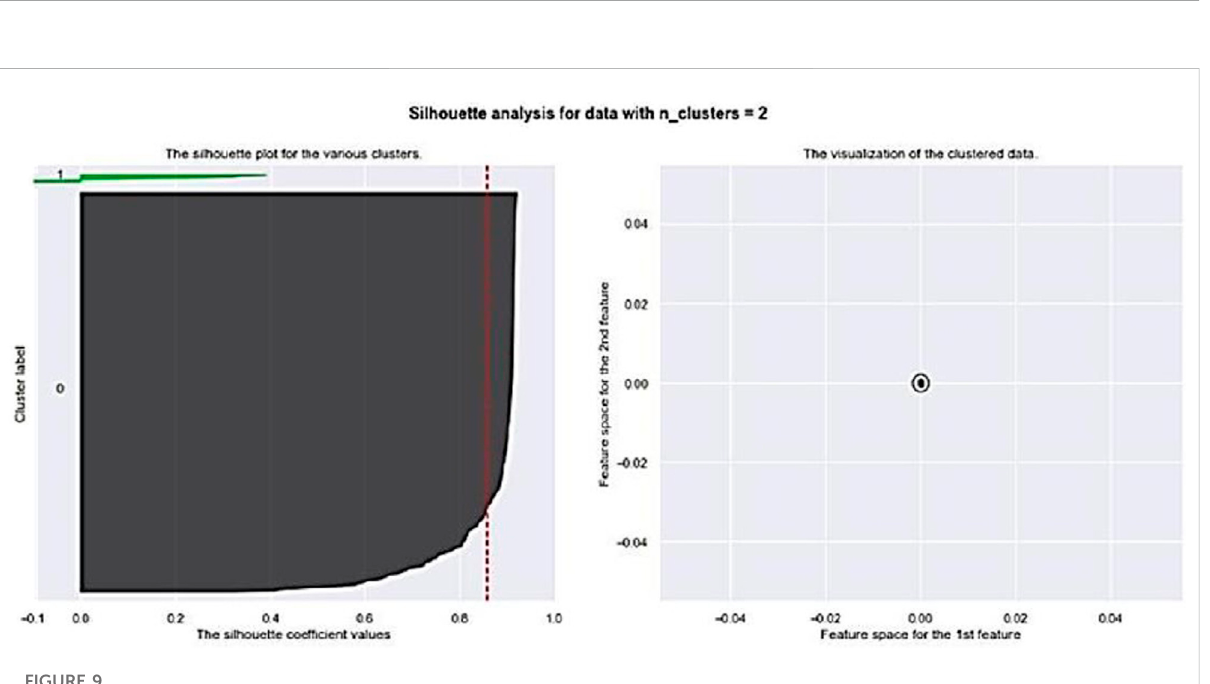
fi nd the optimal number of clusters. The silhouette method measures the average distance between the data points of a cluster ’ s members compared to those of alternative clusters (Rousseeuw, 1987). This silhouette method ismeasured differently for each clustering method.